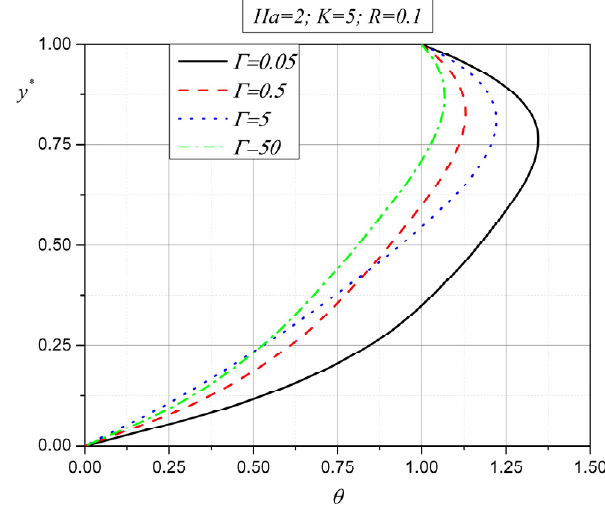
Figure 4. Influence of spin viscosity parameter Γ on dimensionless temperature θ .